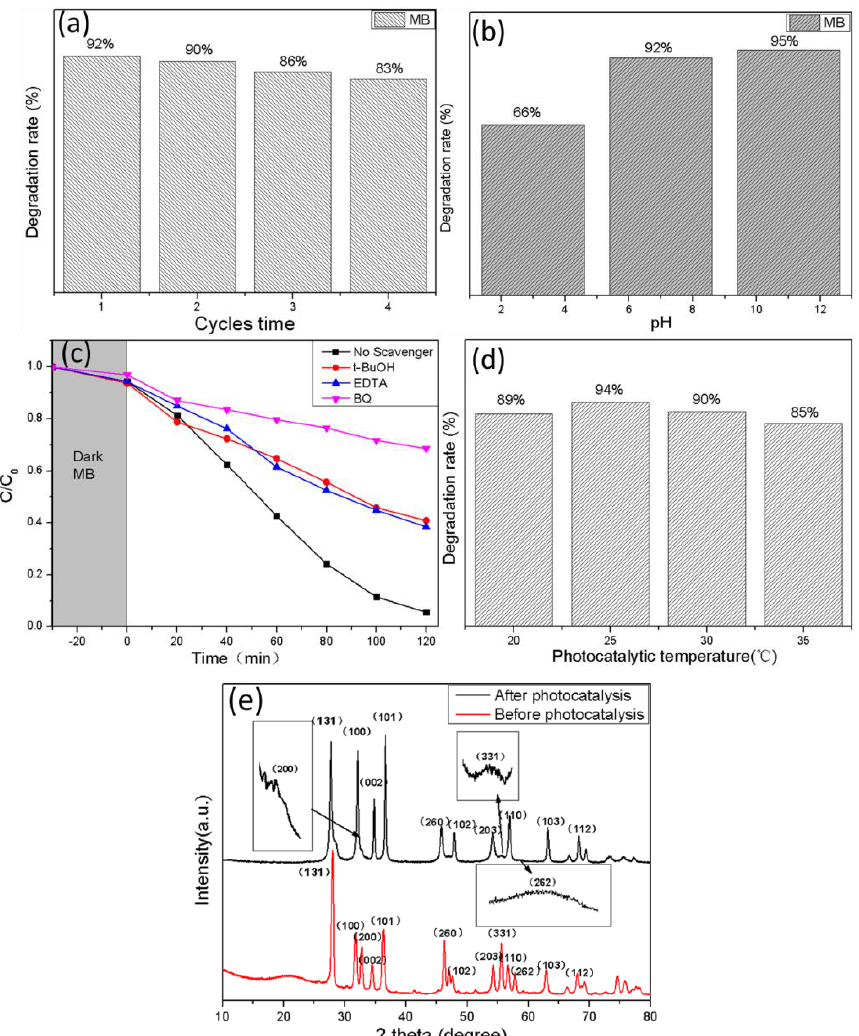
Figure 10. ( a ) Recycling test of photocatalytic MB degradation over BZO catalyst under visible light. ( b ) Degradation rate of BZO at different pH values. ( c ) Photocatalytic activity of BZO for degradation of MB with different quenchers. ( d ) Degradation rate at different temperatures. ( e ) XRD images before and after photocatalysis.